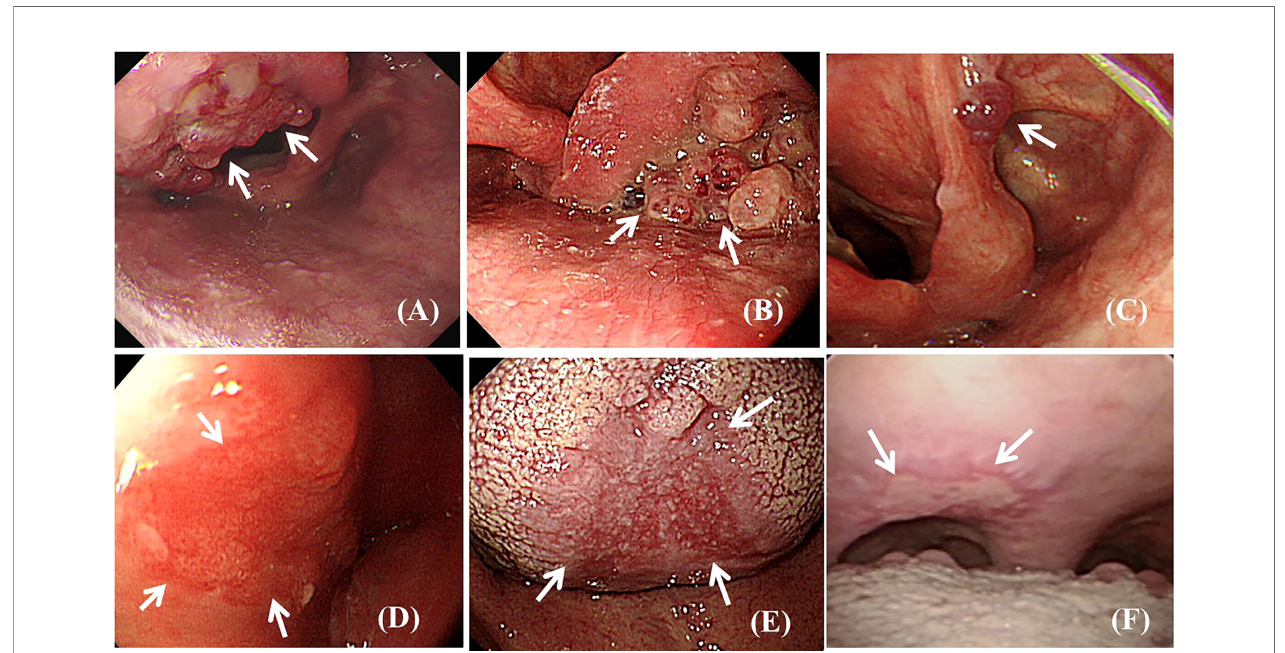
FIGURE 2 | Endoscopic view of observable abnormal fi ndings (arrows). (A) Polypoid squamous cell carcinoma lesion at the epiglottis. (B) Polypoid squamous cell carcinoma lesion at the left side piriform sinus. (C) Polypoid low-grade dysplasia lesion at the aryepiglottic fold. (D) Super fi cial fl at squamous cell carcinoma lesion at